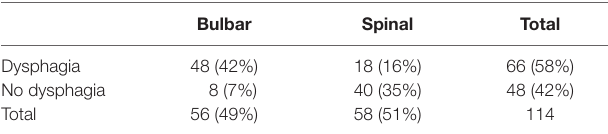
TaBle 1 | als patients with or without dysphagia at baseline according to the spinal or bulbar onset.